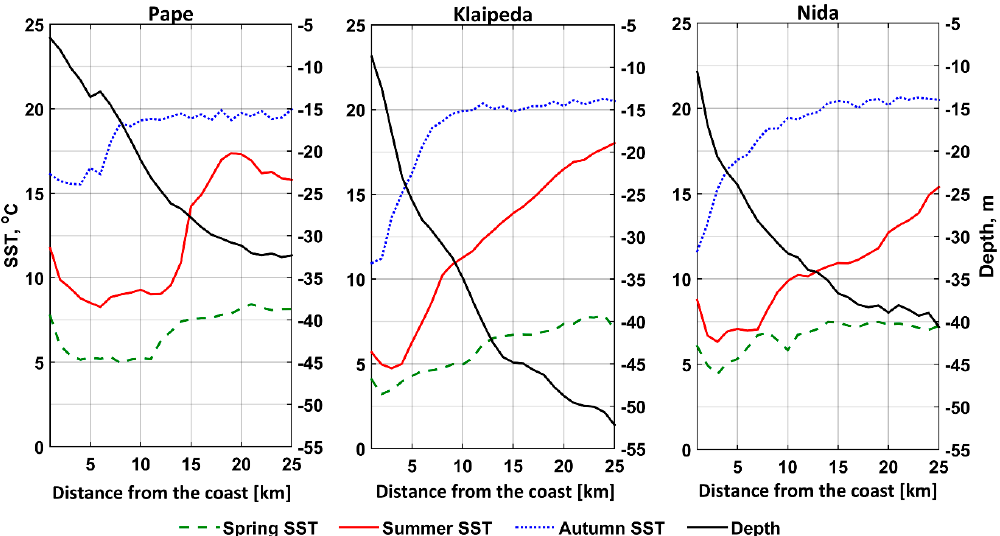
Figure 3. Typical SST and bathymetry profiles in the Baltic Sea near Pape, Klaipeda, and Nida. The green-dashed line denotes the spring SST, the red solid line denotes the summer SST, and the blue dotted line denotes the autumn SST. The black solid line corresponds to the bathymetry profiles (denoted as “Depth”).